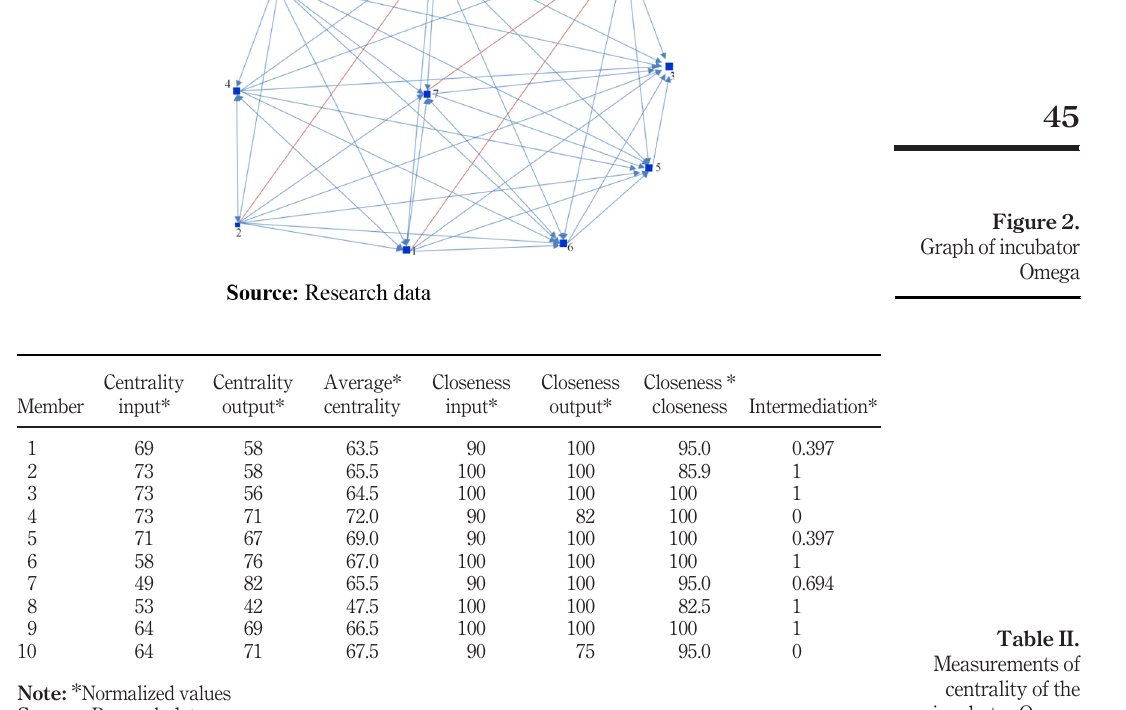
Table II. Measurements of centrality of